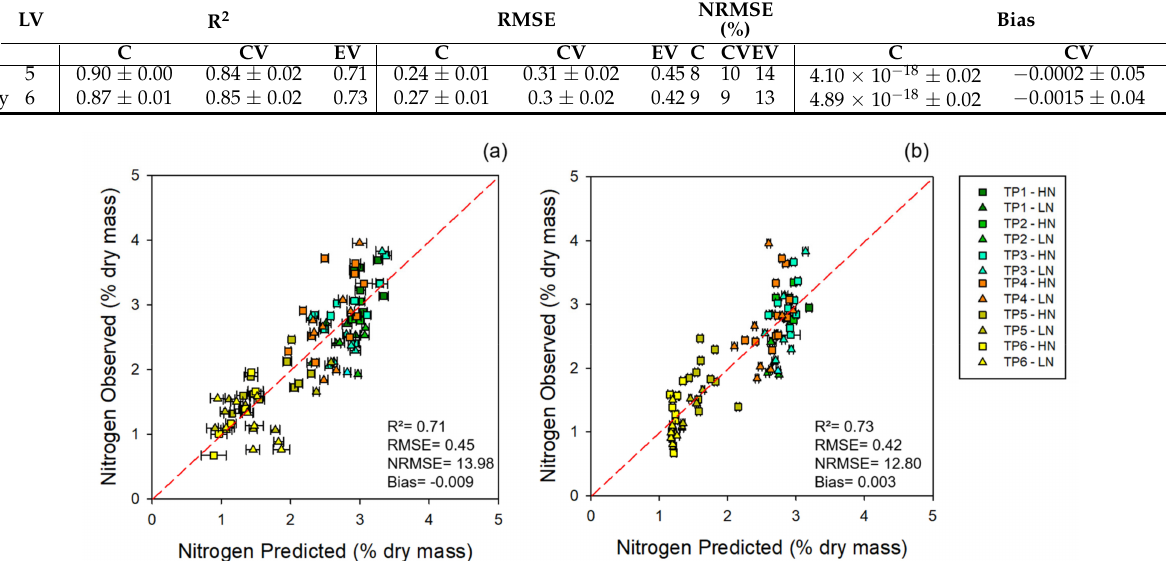
Figure 1. Models for 2017: observed vs. predicted external validation values of nitrogen levels from the 2017 dataset. ( a ) External validation of nitrogen estimates using leaf-level spectral measurements. ( b ) External validation of nitrogen estimates using canopy-level spectral measurements. Error bars for estimated values represent the standard deviation generated from 500 model permutations using an 80:20 calibration:cross-validation approach. Dashed line: 1:1 relationship. R 2 : model goodness of fit; RMSE: root-mean-square error (% dry mass); NRMSE: normalized root-mean-square error (%). TP1, time point 1 = booting (Zadoks 45); TP2, time point 2 = onset of heading (Zadoks 50); TP3, time point 3 = heading (Zadoks 58); TP4, time point 4 = flowering (Zadoks 60); TP5, time point 5 = post-anthesis (Zadoks 68); TP6, time point 6 = maturity (Zadoks